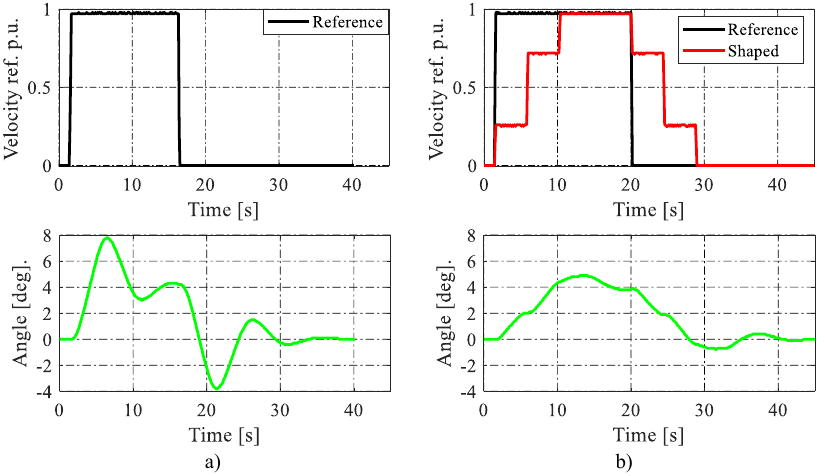
Figure 5. ( a ) Full slew movement without the input shaper and ( b ) results obtained with the EI input shaper